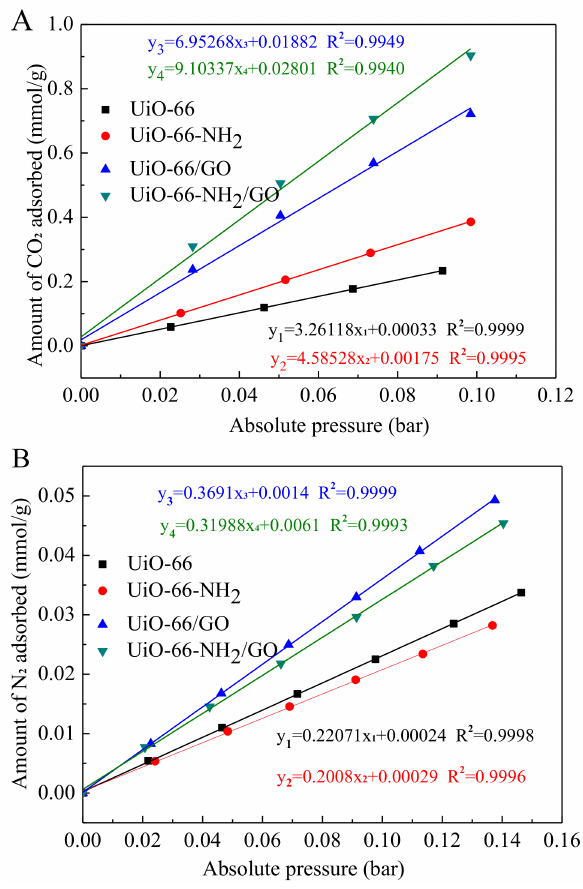
Figure 10. Initial slopes calculation for CO 2 ( A ) and N 2 ( B ) collected at 298